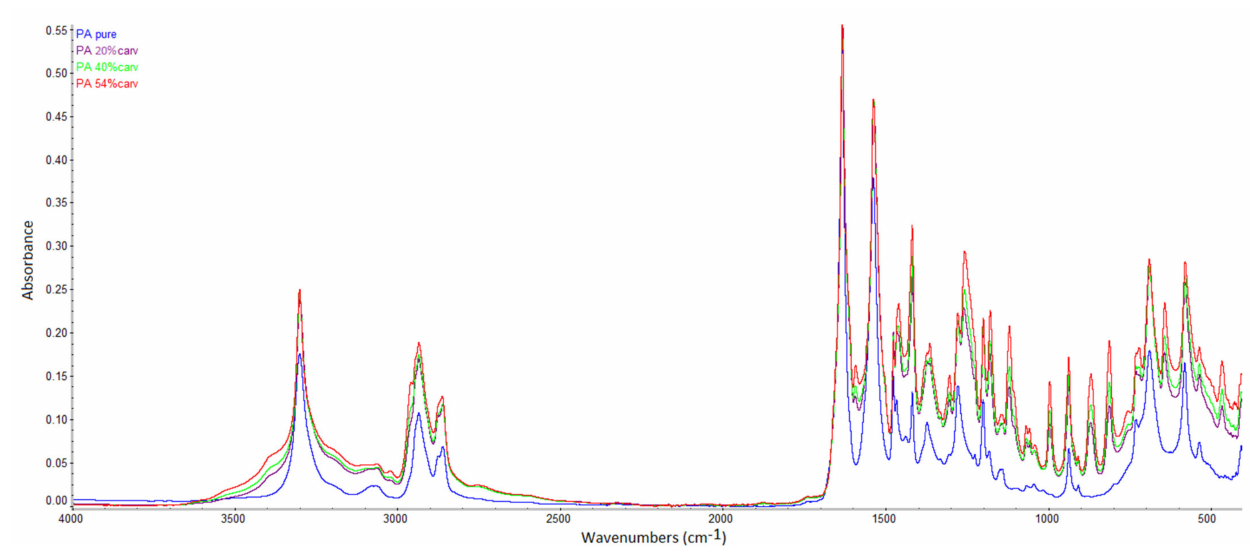
Figure A5. Spectra of neat and carvacrol-impregnated polyamide membranes.